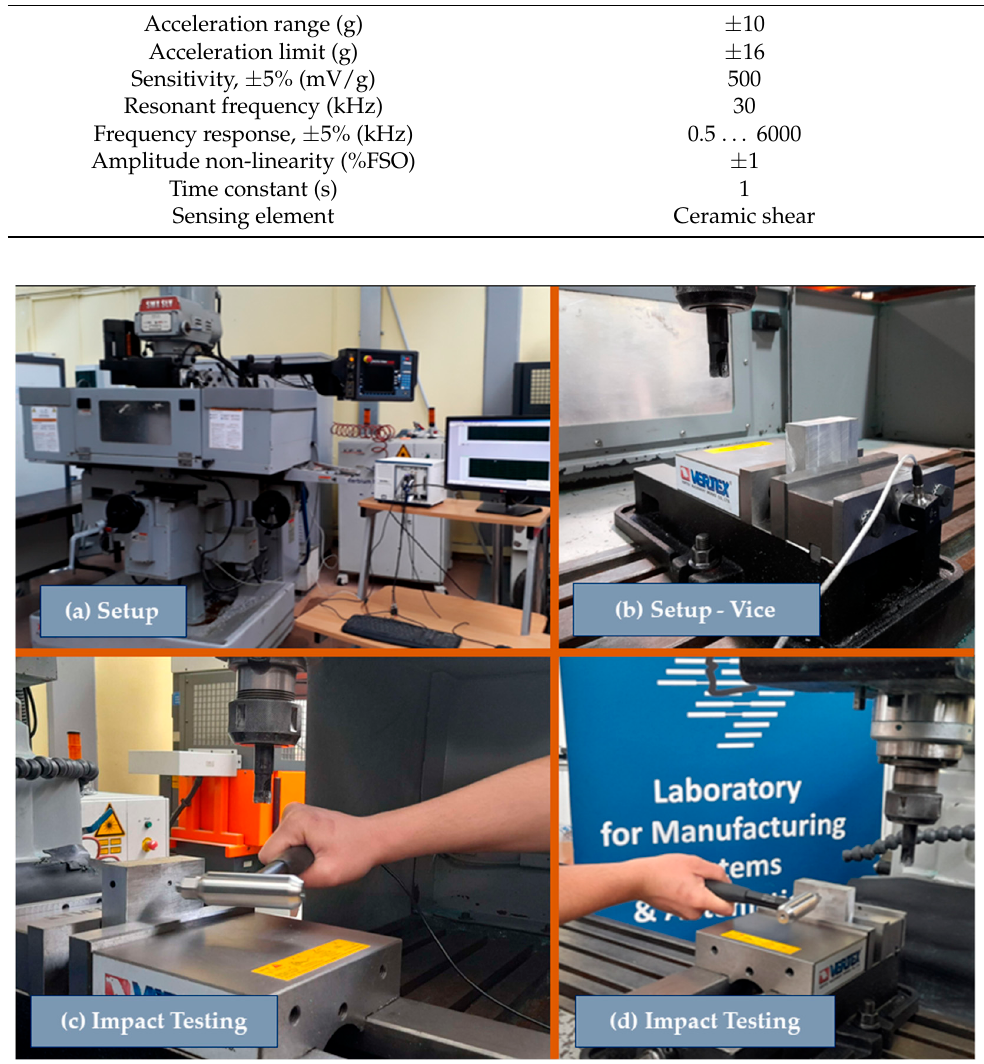
Figure 2. Experimental setup for impact hammer testing. ( a ) Setup ( b ) Setup-Vice ( c ) Impact Testing ( d ) Impact testing, 2nd